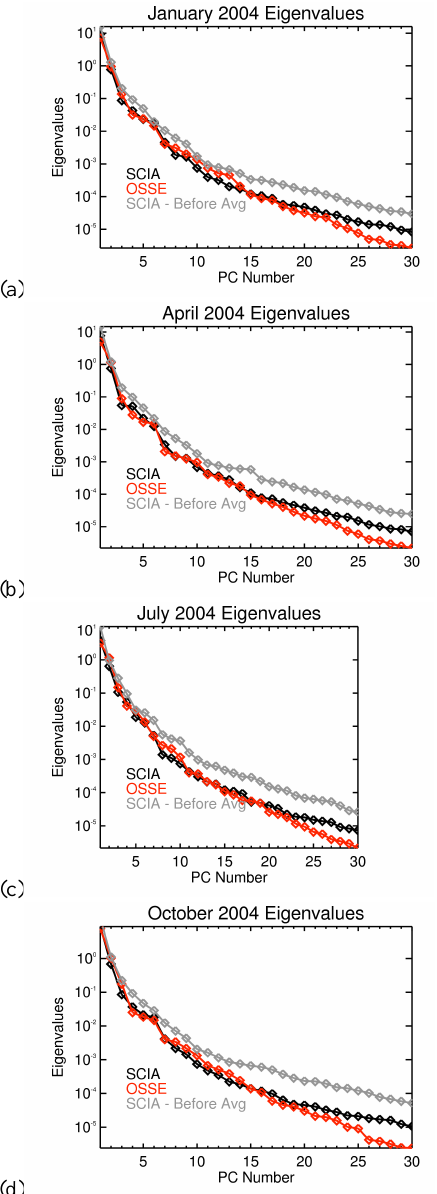
Fig. 2. The first 30 eigenvalues for the January (a) , April (b) , July (c) , and October (d) 2004 SCIAMACHY and OSSE Reflectance PCs. The difference in shape between each of the grey lines and the black lines shows how well the SCIAMACHY data resampling performed prior to PCA aligned the SCIAMACHY distribution of information with that of the OSSE.